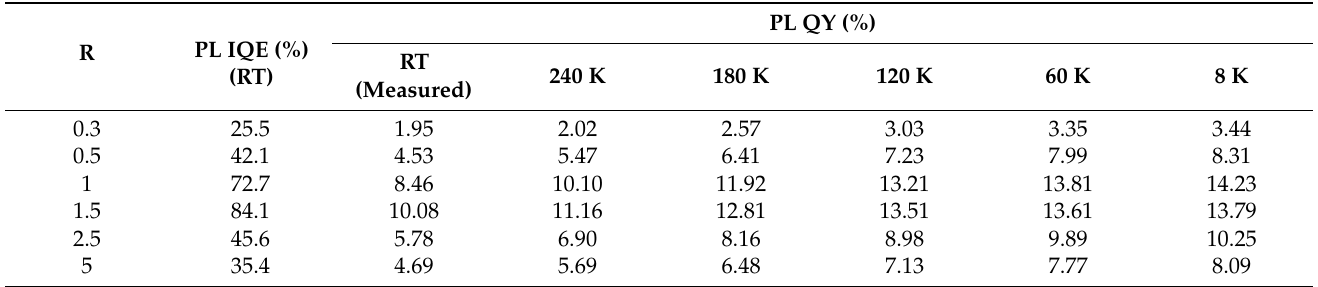
Table 2. Summary of the PL IQE values (average) at room temperature and the temperature- dependent PL QY values (average) of a-SiN x O y